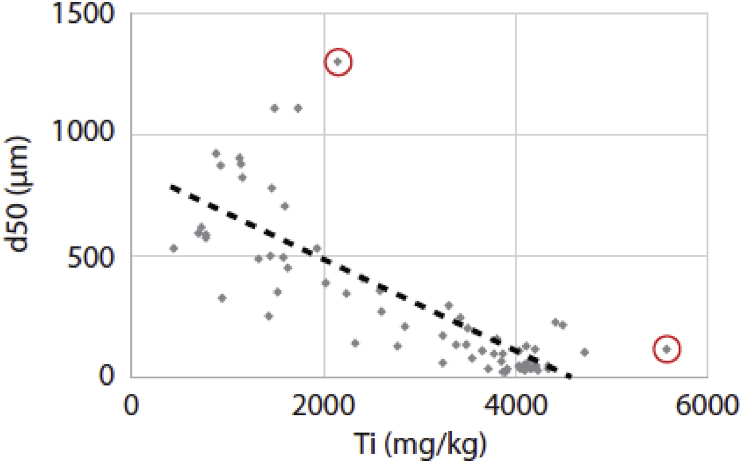
Linear regression between Ti concentration and the d50 value (grain-size analysis) showing a negative and significant relationship (y = −0.1883x + 863.54). Red circles refer to outliers. See text for details.